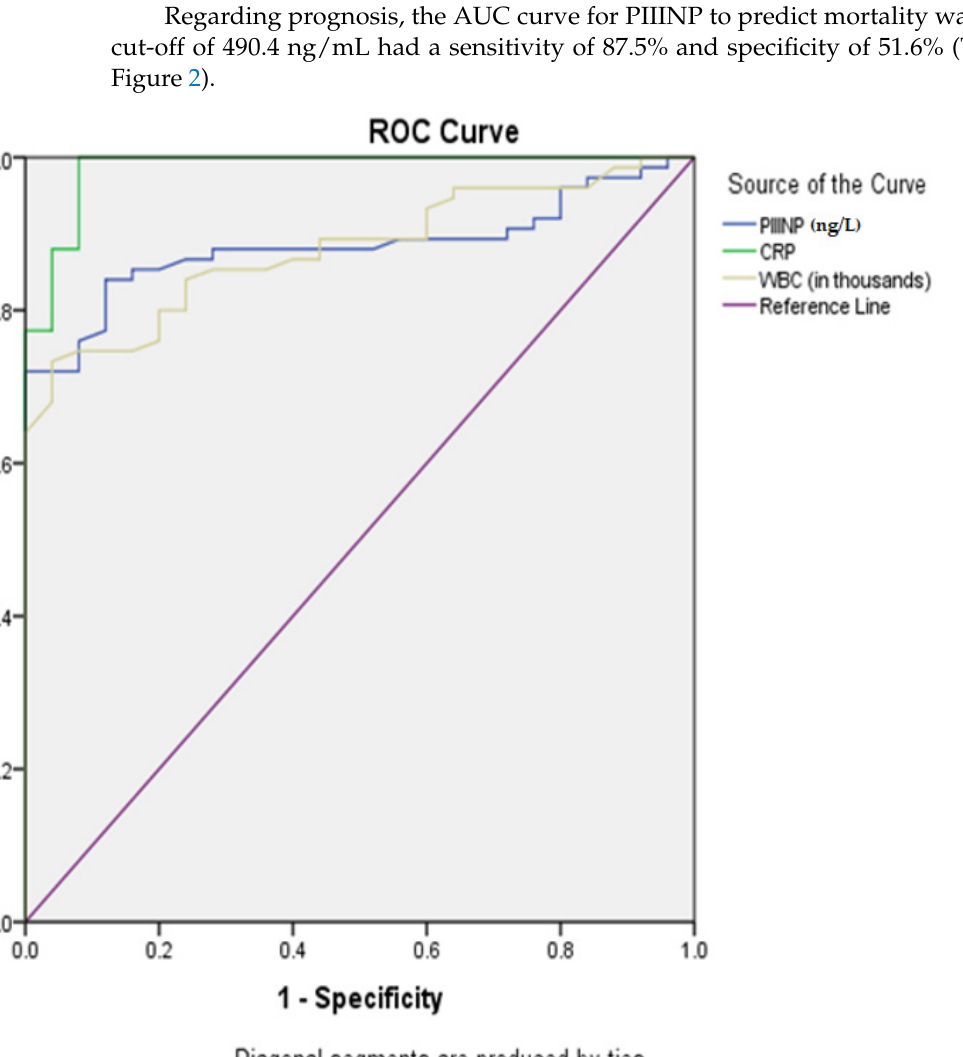
Figure 1. Receiver-operating characteristic (ROC) curve for prediction of sepsis severity. Regarding prognosis, the AUC curve for PIIINP to predict mortality was 0.651; the cut-off of 490.4 ng/mL had a sensitivity of 87.5% and specificity of 51.6% (Table 6 and Figure 2). Table 6. Validity of PIIINP, CRP, PRISM and PIM for prediction of mortality. PIIINP